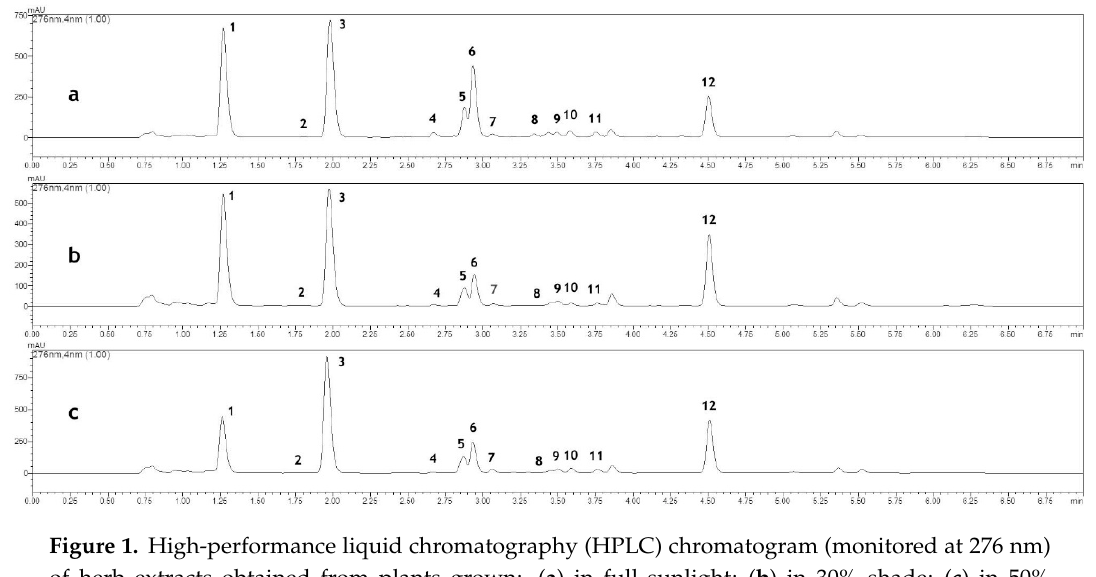
Values are mean ± SD; values marked in rows with different letters differ at p < 0.05;* p < 0.05 (in columns).